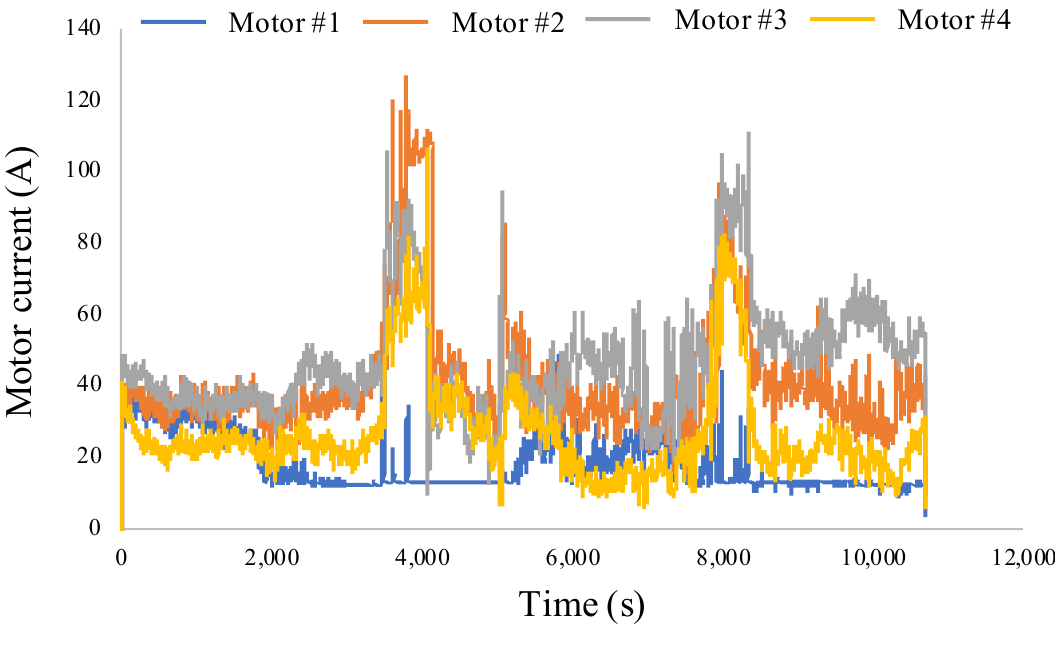
Figure 7. Testing results of traction.